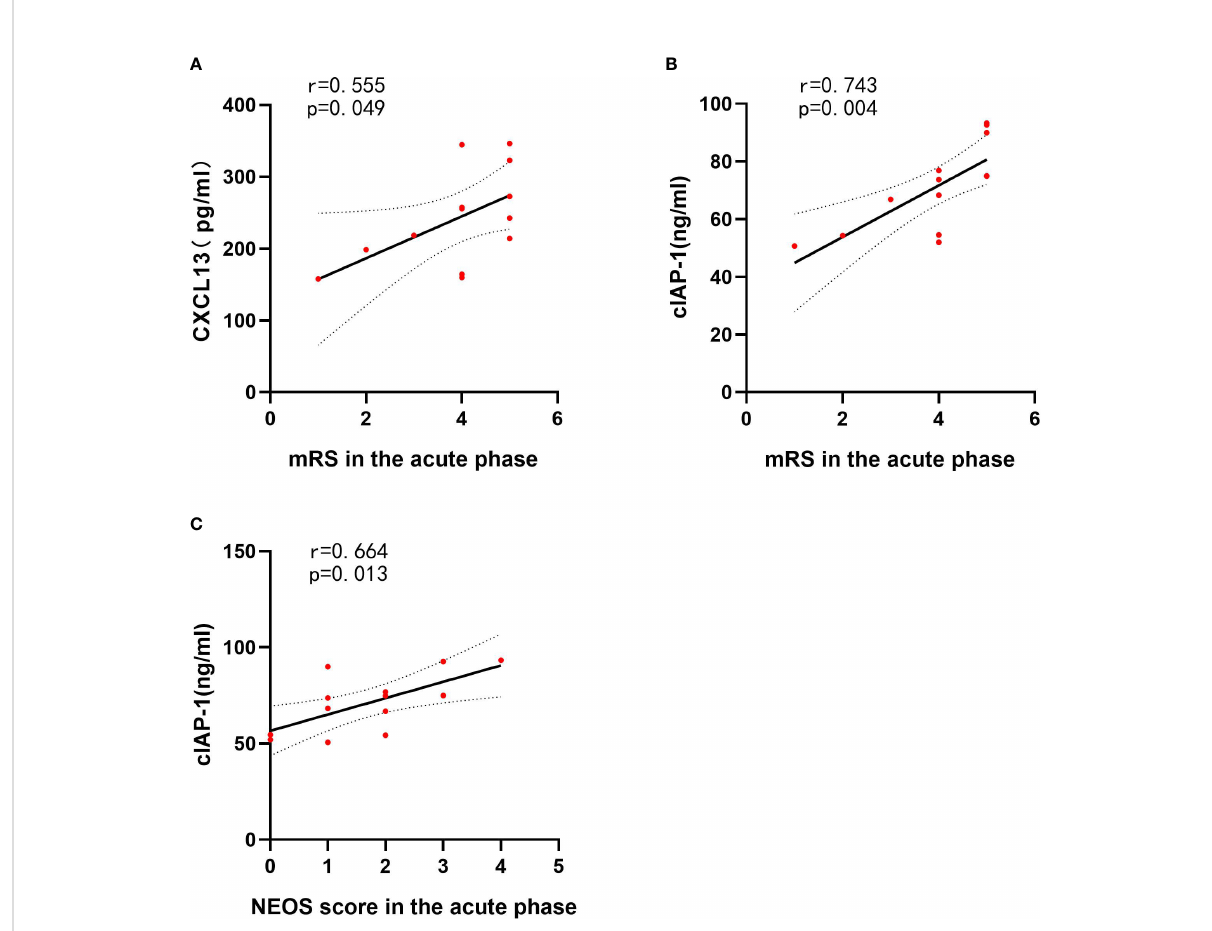
FIGURE 5 CSF cytokines and in fl ammatory mediator levels correlated with clinical features of anti-NMDAR encephalitis patients. The p -values represent the results of the Spearman ’ s rank correlation coef fi cient or point-biserial correlation coef fi cient. p < 0.05. CSF, cerebrospinal fl uid; NMDAR, anti-N-methyl-D- aspartate receptor; mRS, modi fi ed Rankin Scale; NEOS, anti-NMDAR Encephalitis One-Year Functional Status; CXCL13, CXC chemokine ligand 13; MCSF, macrophage colony-stimulating factor; NLRP3, nucleotide binding oligomerization domain-like receptor protein 3. (A) The correlations between CXCL13 and mRS in the acute phase of anti-NMDAR encephalitis patients. (B) The correlations between cIAP-1 and mRS in the acute phase of anti- NMDAR encephalitis patients. (C) The correlations between cIAP-1 and NEOS score in the acute phase of anti-NMDAR encephalitis